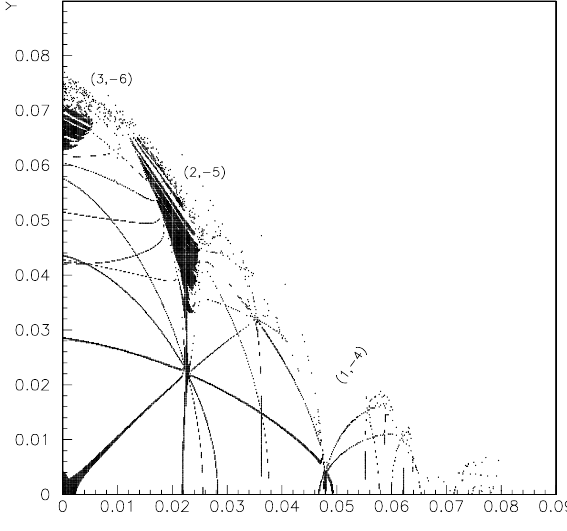
FIG. 6. Network of resonances after the summed-resonance compensation.